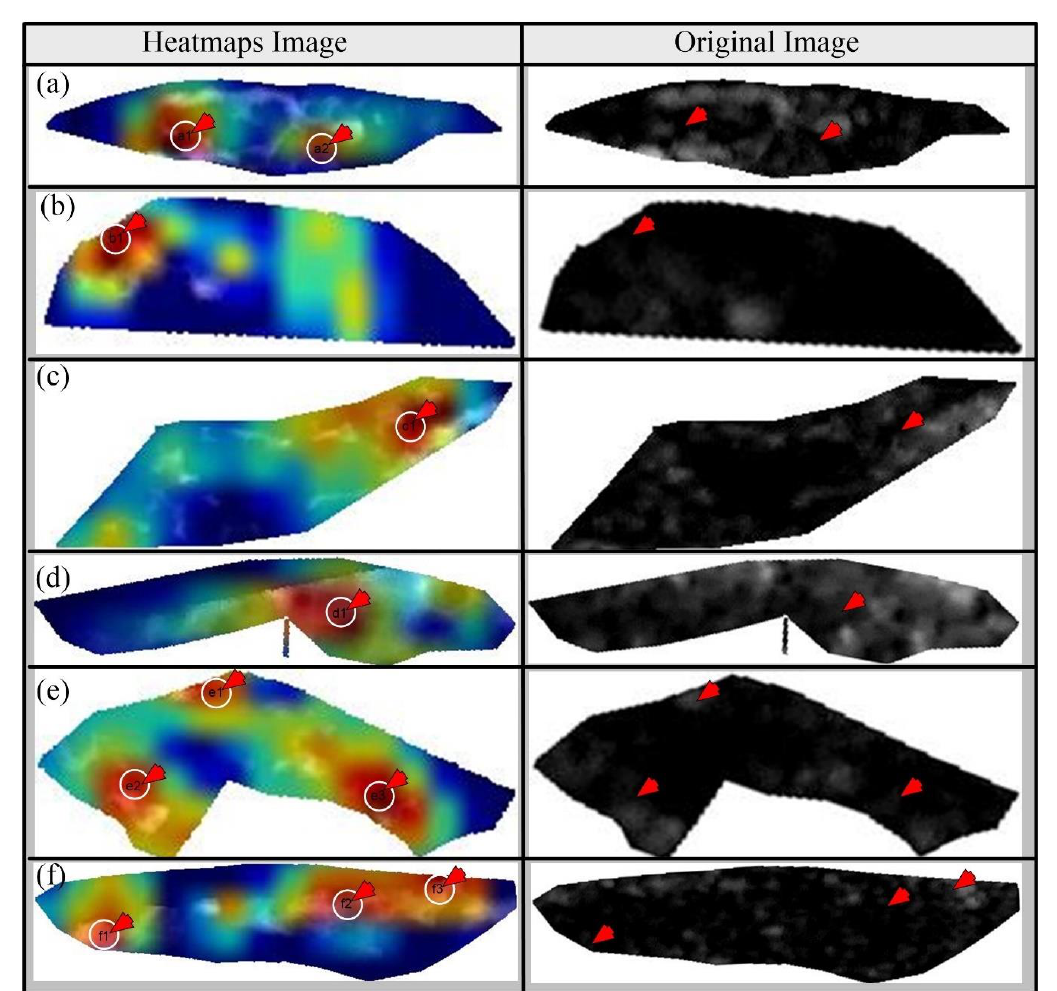
Table 6. Euclidean distance between biomarker pairs.